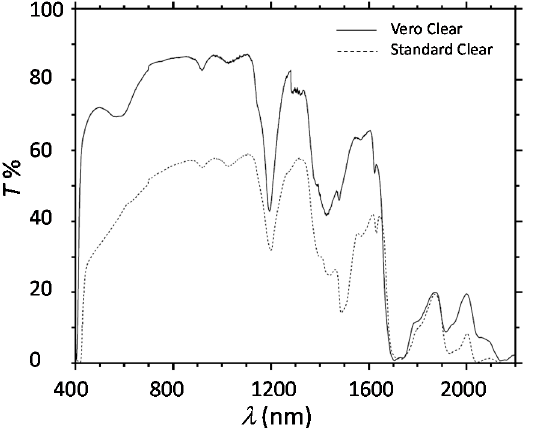
Figure 2. Measured transmission spectra of polished SC and VC slabs in the VIS/NIR. The similar UV band-edge (below λ = 420 nm) corresponds to the 405 nm absorption of the photo-initiator that polymerises the material. The absorption bands associated with C–H stretches ( λ ~1200, 1500 and 1900 nm) are all shifted to shorter wavelengths for the VC sample, consistent with fluorination. The dip observed around λ ~570 nm is probably an interference fringe from the slab arising from back reflection from the back surface, consistent with the significantly improved transmission.